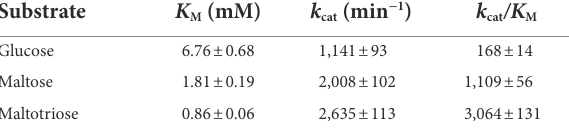
TABLE 2 Kinetic parameters of rPSGT for acceptor specificity.